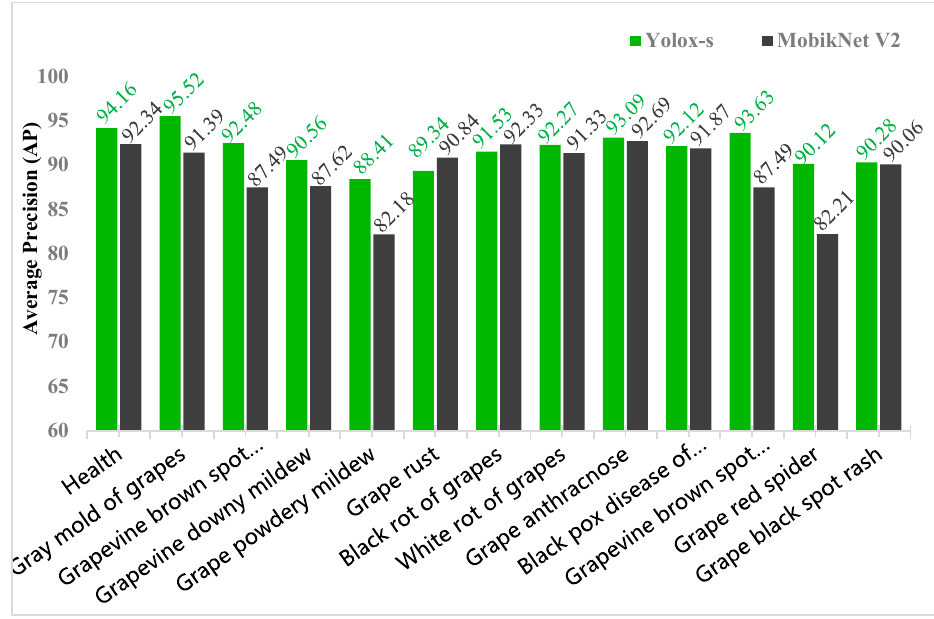
Figure 3. Average precision values of Yolox_s and MobileNet V2 detection for 12 pests and diseases in the public dataset.